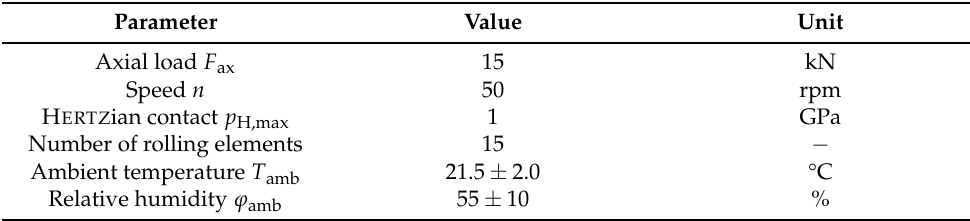
Table 2. Experimental